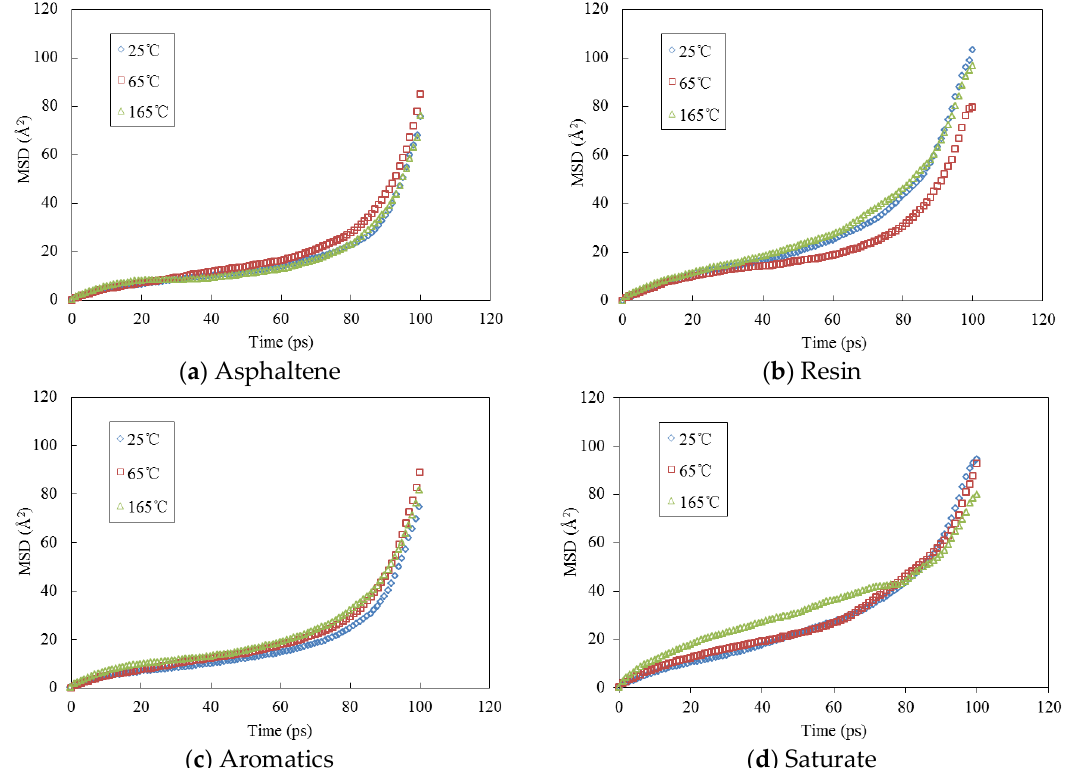
Figure 3. Effects of temperature on MSD of four asphalt components on the surface of Al 2 O 3 : ( a ) Asphaltene; ( b ) Resin; ( c ) Aromatics; ( d ) Saturate.